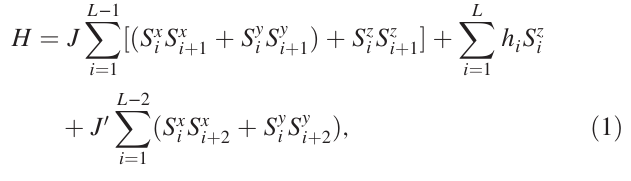
Figure 2 benchmarks the location of the transition in Eq. (1) using the half-chain entanglement entropy S and the